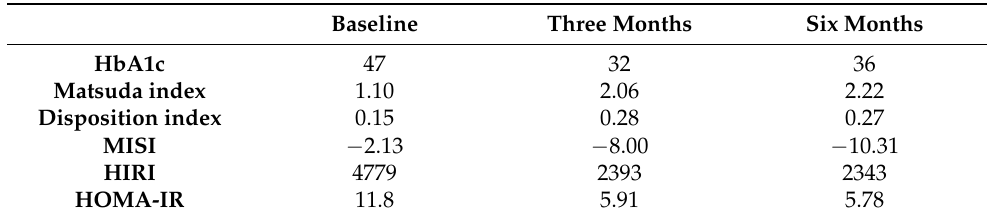
Table 5. HbA1c and T2D indices derived from OGTT for participant A at baseline and after three months and six months of intervention.